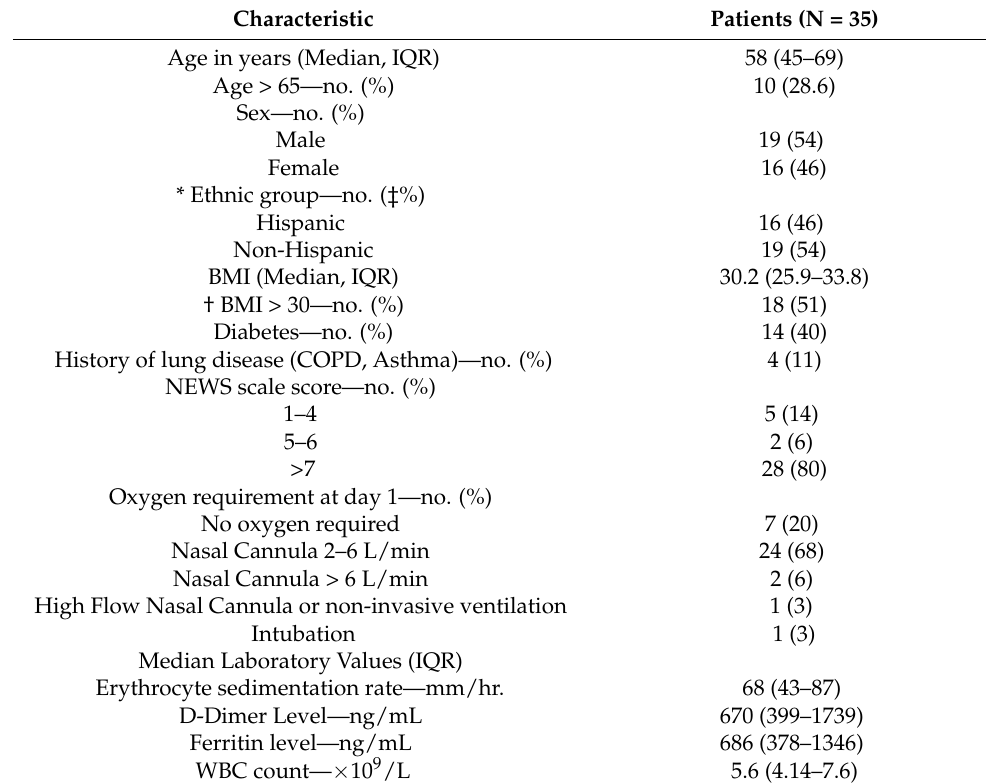
Table 1. Patient demographics and